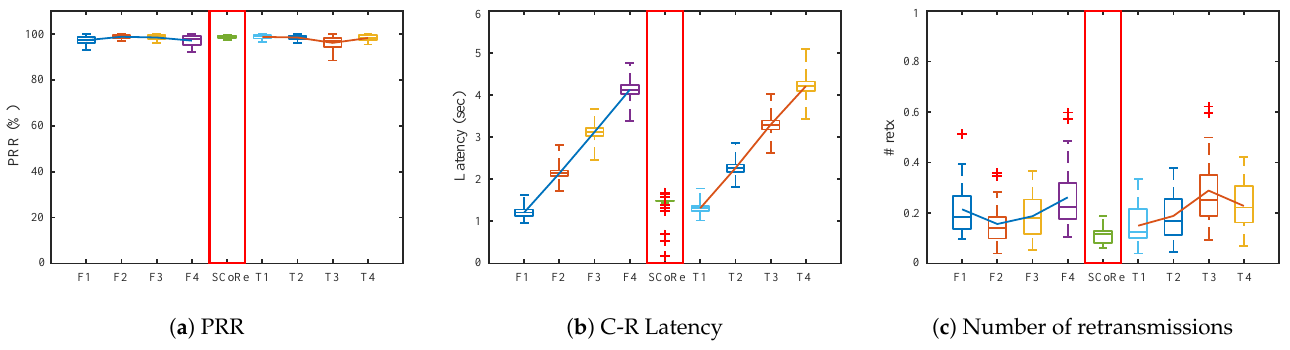
Figure 11. Results from the testbed experiments with M = 3, T C = 200 ms, K = 5, and varying T R